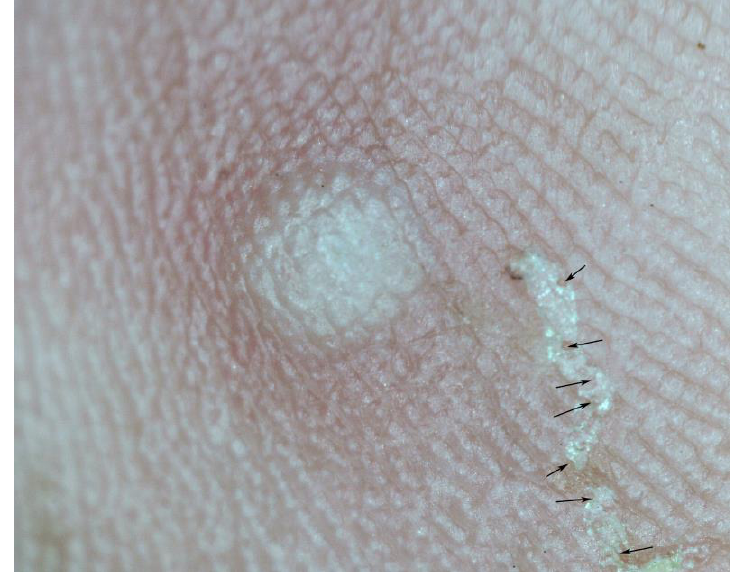
Figure 10. Serpiginous tunnel with multiple entry and exit points (arrows); magnification 15-fold.